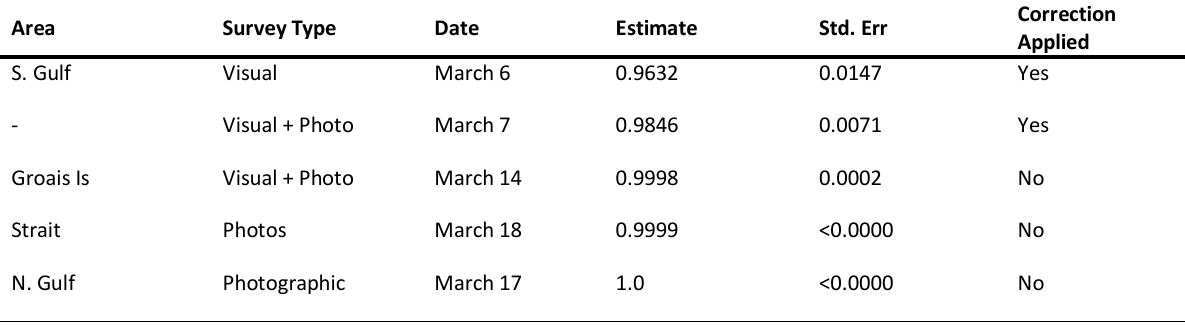
Table 2. Estimated proportions of Northwest Atlantic Harp Seal pups on the ice at the time of the surveys.